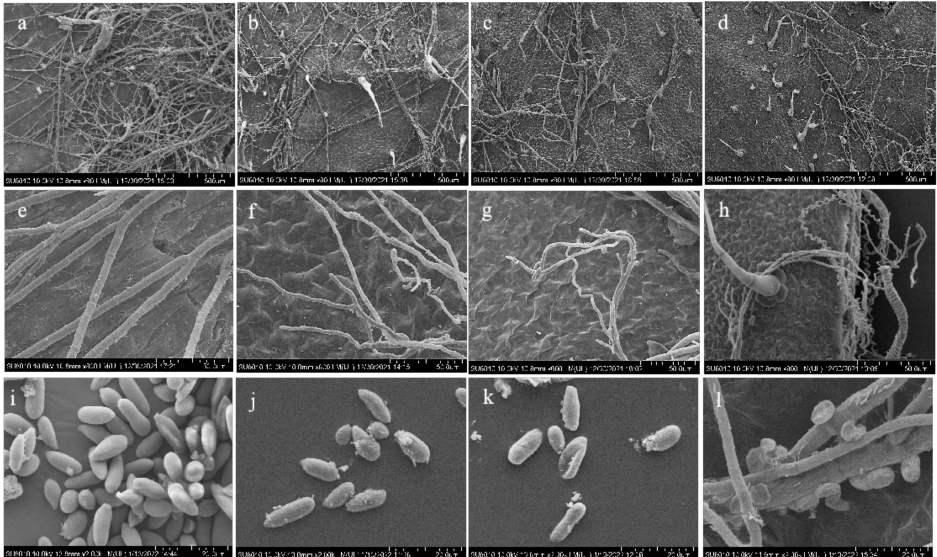
Figure 6. Effects of wuyiencin and ε -PL on the filaments and conidia of B. cinerea on tomato leaves. ( a – d ): The density of mycelia treated with distilled water, wuyiencin at 60 µ g/mL, ε -PL at 1500 µ g/mL, wuyiencin at 60 µ g/mL + ε -PL at 1500 µ g/mL for 72 h. ( e – h ): The mycelial morphology after the same treatments as in ( a – d ). ( i – l ): The morphology of conidia after the same treatments as in ( a – d